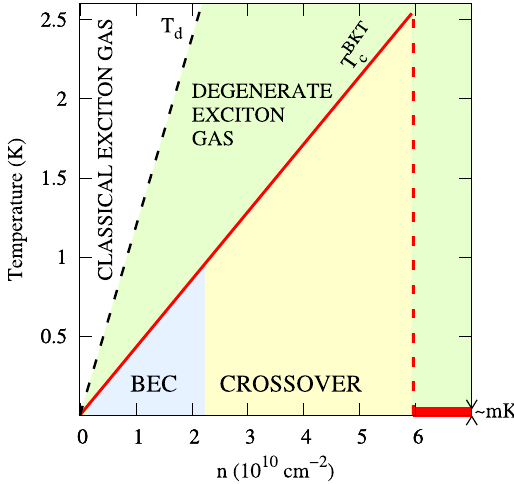
Fig. 4 Phase diagram. T BKT is the super fl uid transition temperature. c n is the density of the electrons and holes. T d is the degeneracy temperature for the exciton gas. The super fl uid BEC and BCS – BEC crossover regimes are indicated. Above n ~ 6 × 10 10 cm − 2 , the super fl uid transition temperature is in the mK